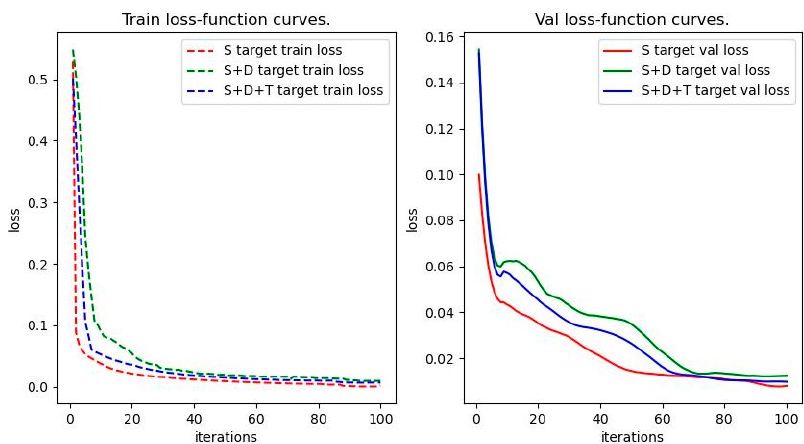
Figure 8. Loss function curves for training and validation.